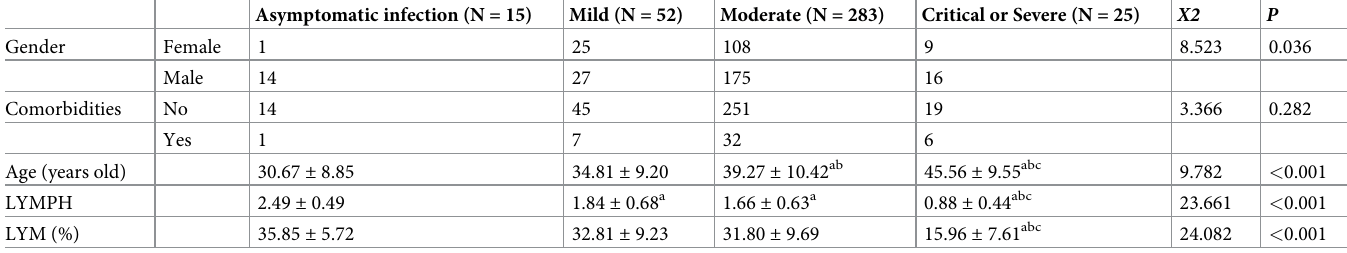
Table 3. Comparison of gender, comorbidities, age, LYMPH, and LYM% between groups with different levels of disease severity. Asymptomatic infection (N = 15) Mild (N = 52) Moderate (N = 283) Critical or Severe (N = 25)